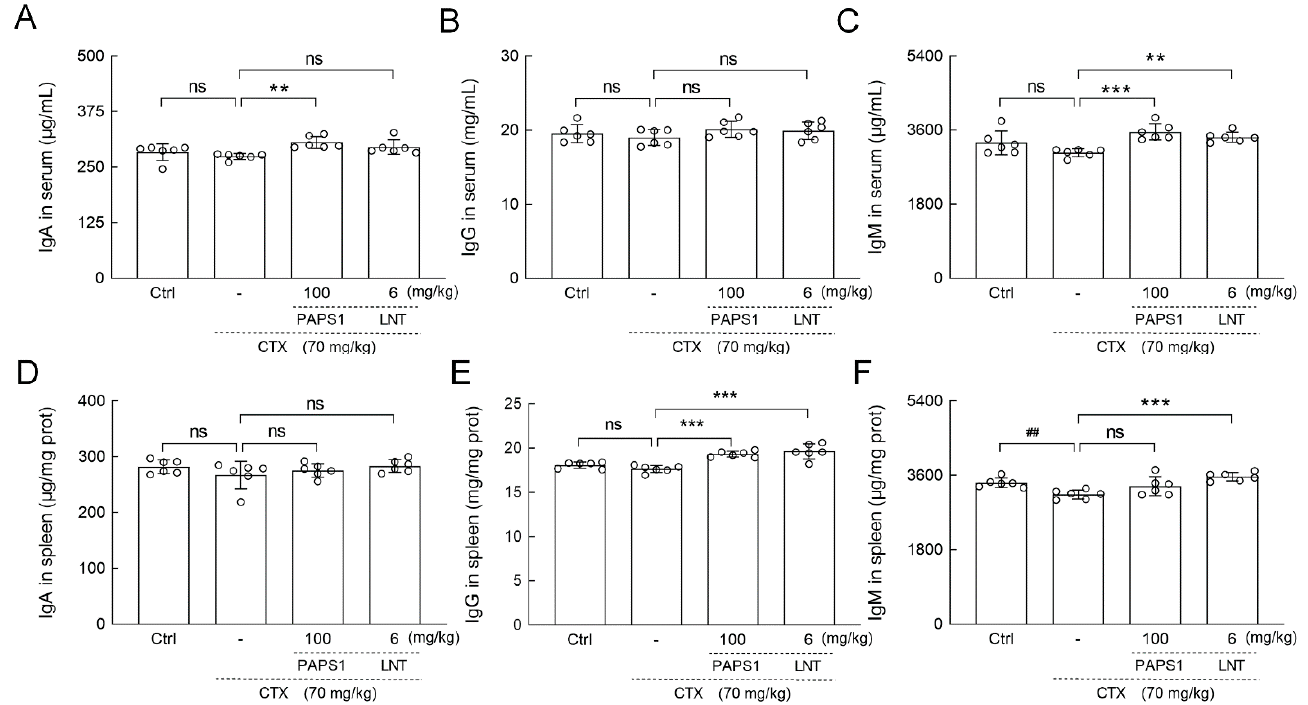
Figure 4. PAPS1 increased the levels of Igs in the spleen and the serum of CTX-immunosuppressed mice. The levels of ( A ) IgA, ( B ) IgG and ( C ) IgM in the serums and ( D ) IgA, ( E ) IgG and ( F ) IgM in the spleens of mice were analyzed by ELISA. The data are presented as the mean ± S.D. ( n = 6) and were analyzed via a one-way ANOVA test followed by Dunn’s multiple comparisons post-hoc